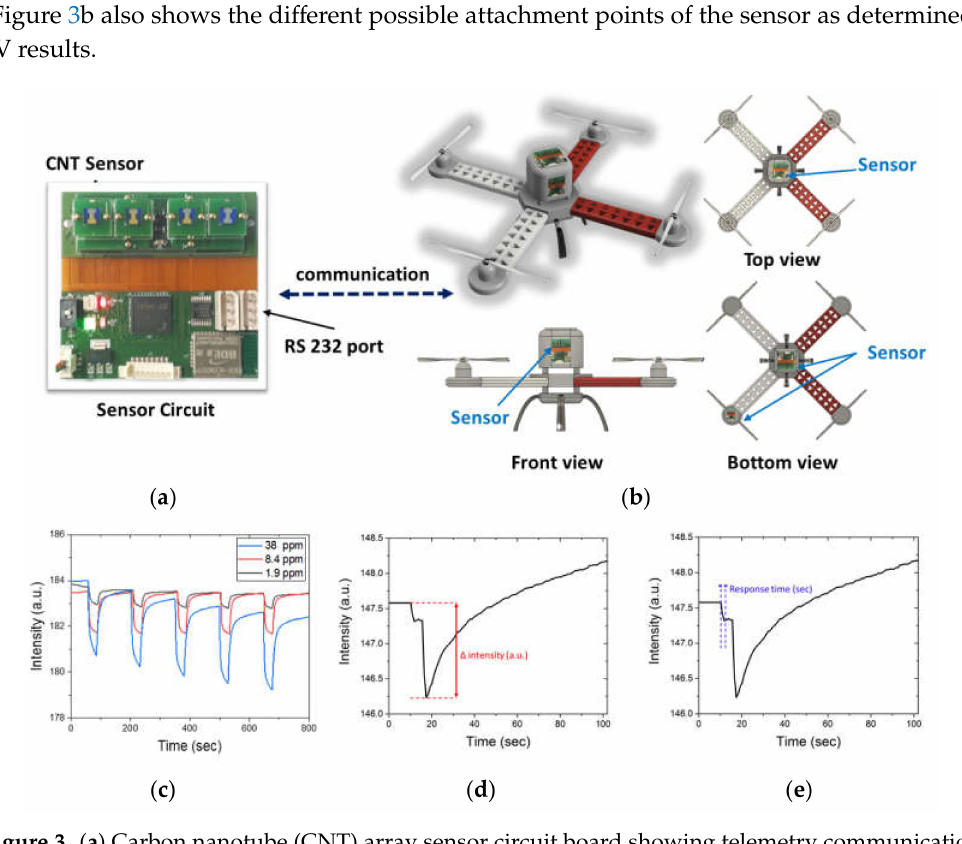
Figure 3. ( a ) Carbon nanotube (CNT) array sensor circuit board showing telemetry communication circuit with four sensor adapters, and ( b ) schematic of a quadrotor drone showing di ff erent attachment points of CNT sensors (top, bottom, middle, and on-rotor). ( c ) Capacitance change graphs with di ff erent dimethyl-methylphosphonate (DMMP) concentration exposure (1.9, 8.4 and 38 ppm) from laboratory scale test. ( d , e ) Change of intensity and response time from our experiments for comparison of each locations’ sensor performance,